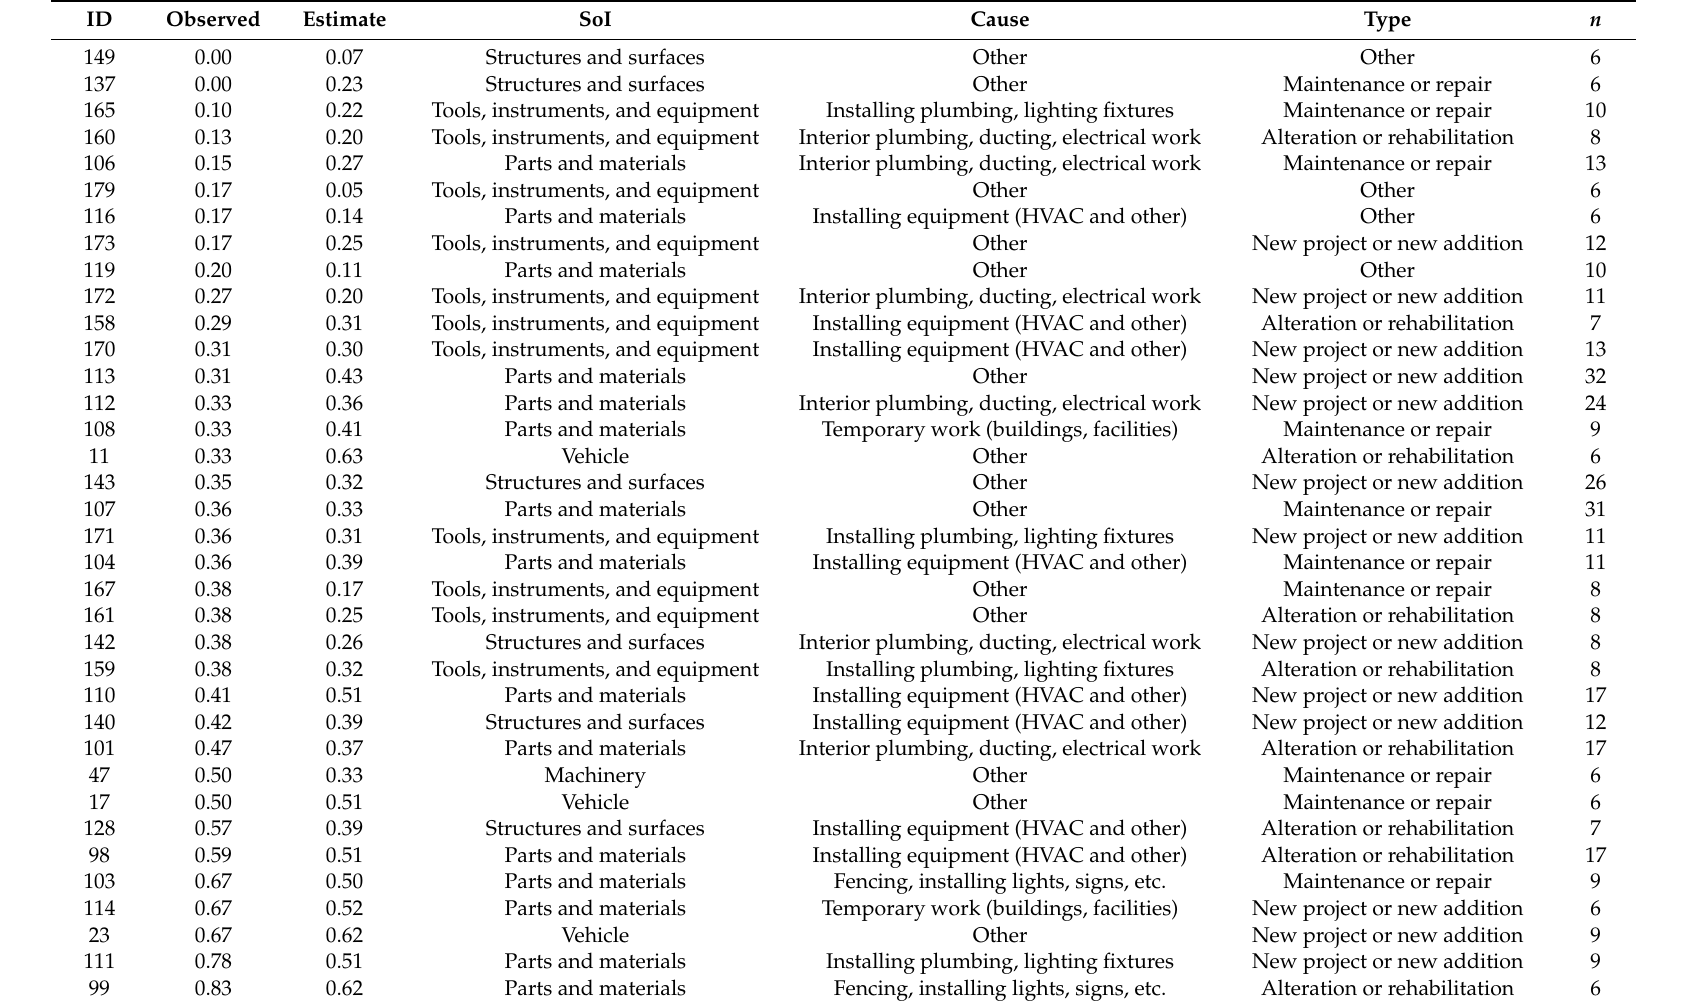
Table 12. Observed and predicted probability of fatal accidents in 36 common covariate